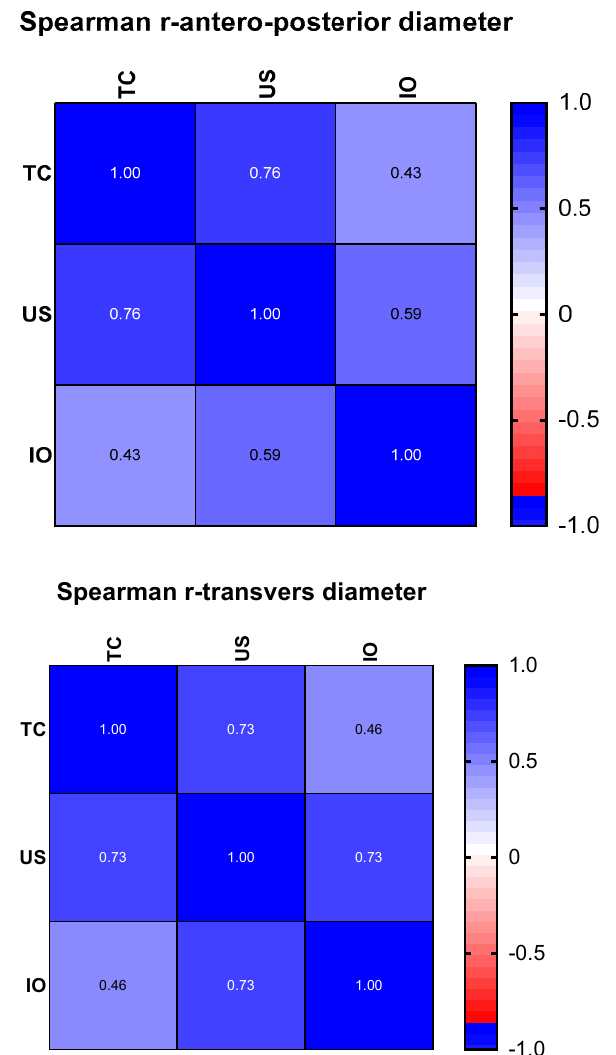
Figure 4. Figure 4. Spearman correlation coefficient (US = ultrasound, TC = computed tomography, IO = in- traoperatively).